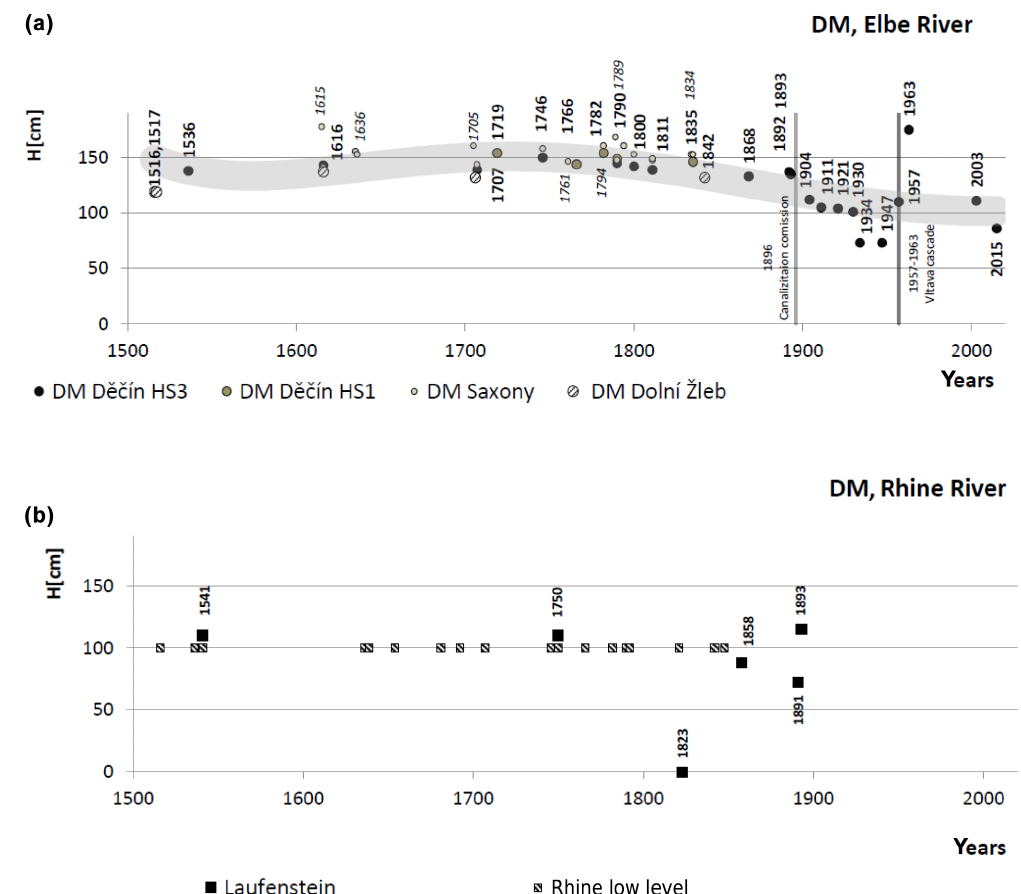
Figure 9. Graphical overview of DM data from the Czech and Saxon areas (a) . The black and grey circles represent the DM minima derived from the hunger stone in Dˇeˇcín, and the hatched circles relate to the stone in Dolní Žleb. This ensemble is completed by minima from the Saxon data (small circles; Table 9). The grey line highlights the trend of DM minima. Graphical overview of DM data from the Rhine basin (b) . Water level minima derived from the Laufenstein DM (black squares) and other epigraphic documentation (hatched squares) (Table 11a,